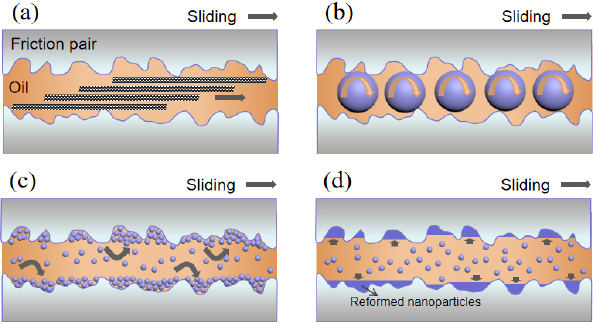
Fig. 14 Four main friction mechanisms: (a) sliding; (b) rolling; (c) polishing or smoothing; and (d) mending or